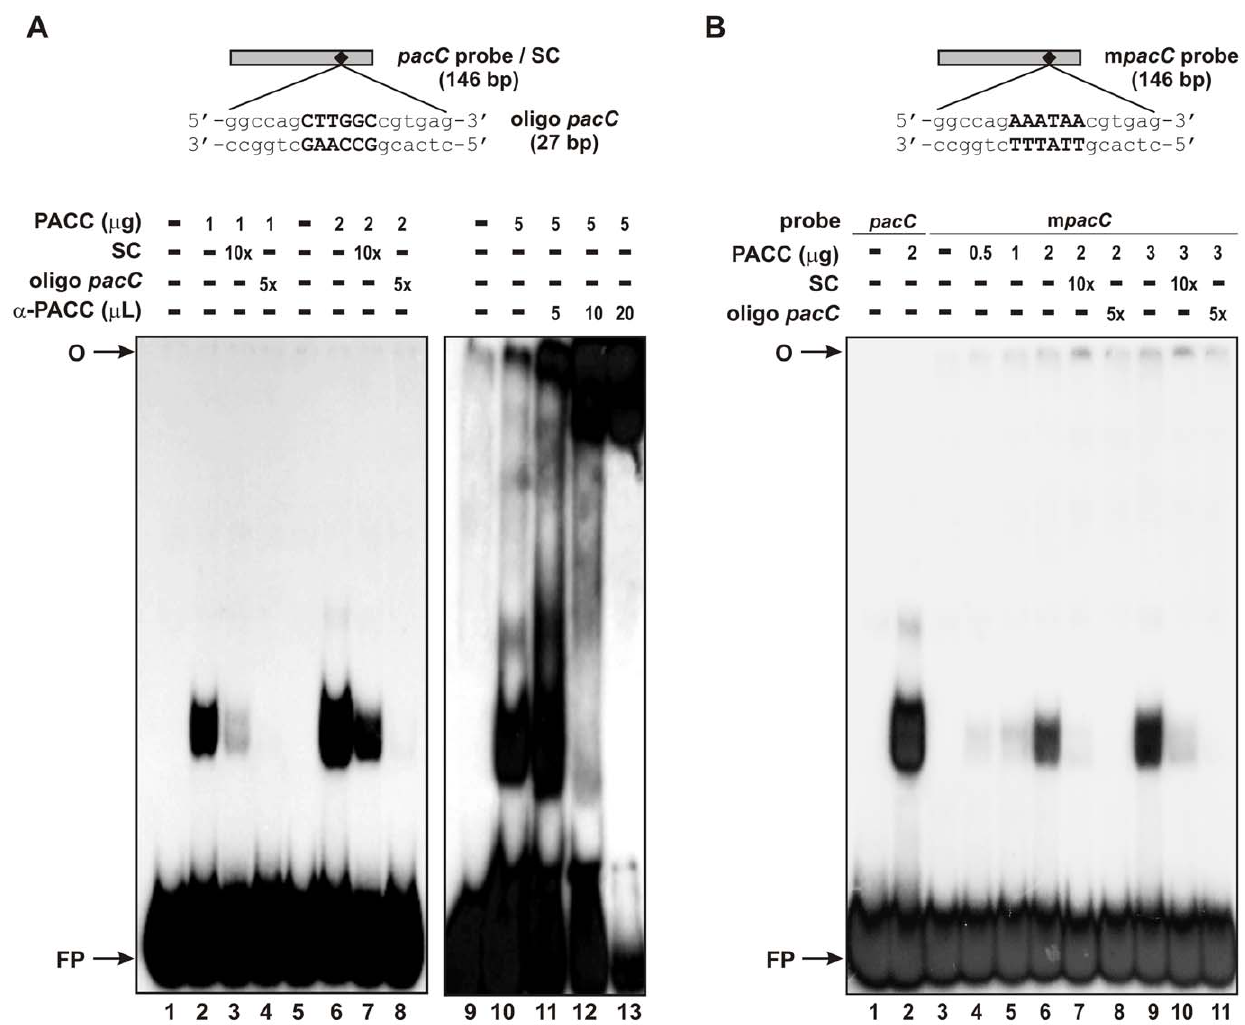
Figure 6. Binding of recombinant PACC to the gsn promoter. (A) Upper panel, schematic representation of the pacC probe and the specific competitor oligo pacC . Lower panels, gel shift analysis using increasing amounts of recombinant PACC in the presence of specific competitors and polyclonal anti-PACC antibody. Lanes 1, 5 and 9, pacC probe, no protein added. Lanes 2, 6 and 10, gel shift analysis using 1.0, 2.0 and 5.0 m g of recombinant PACC. Lanes 3 and 7, gel shift analysis in the presence of the 146 bp specific competitor. Lanes 4 and 8, gel shift analysis using the specific competitor oligo pacC . Lanes 11 to 13, supershift assay using 5.0, 10.0 and 20.0 m L of anti-PACC antibody (1:500). (B) Upper panel, schematic representation of the mutated m pacC probe. Lower panel, gel shift with wild-type and mutated probes. Analysis using different concentrations of recombinant PACC in the presence and in the absence of competitors. Lane 1 and 3, pacC and m pacC probes, respectively, no protein added. Lanes O, gel origin; SC, specific competitor; FP, free